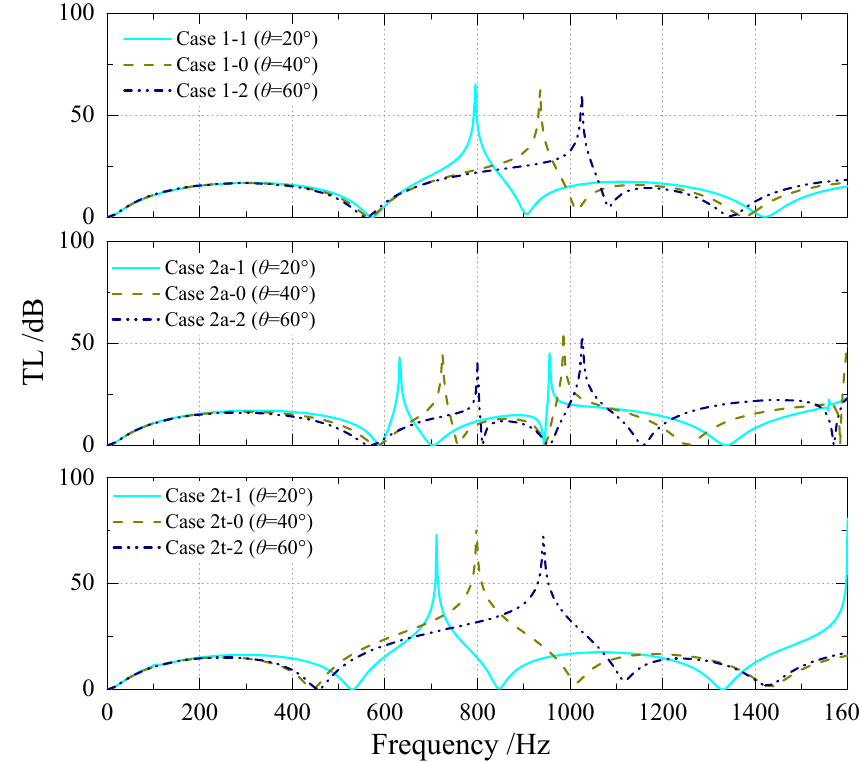
Figure 9. TLs of the RECs with different baffle angles.